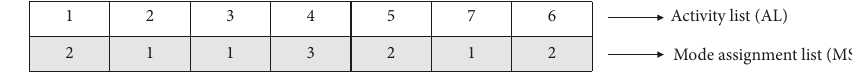
Figure 1: Structure of solution.